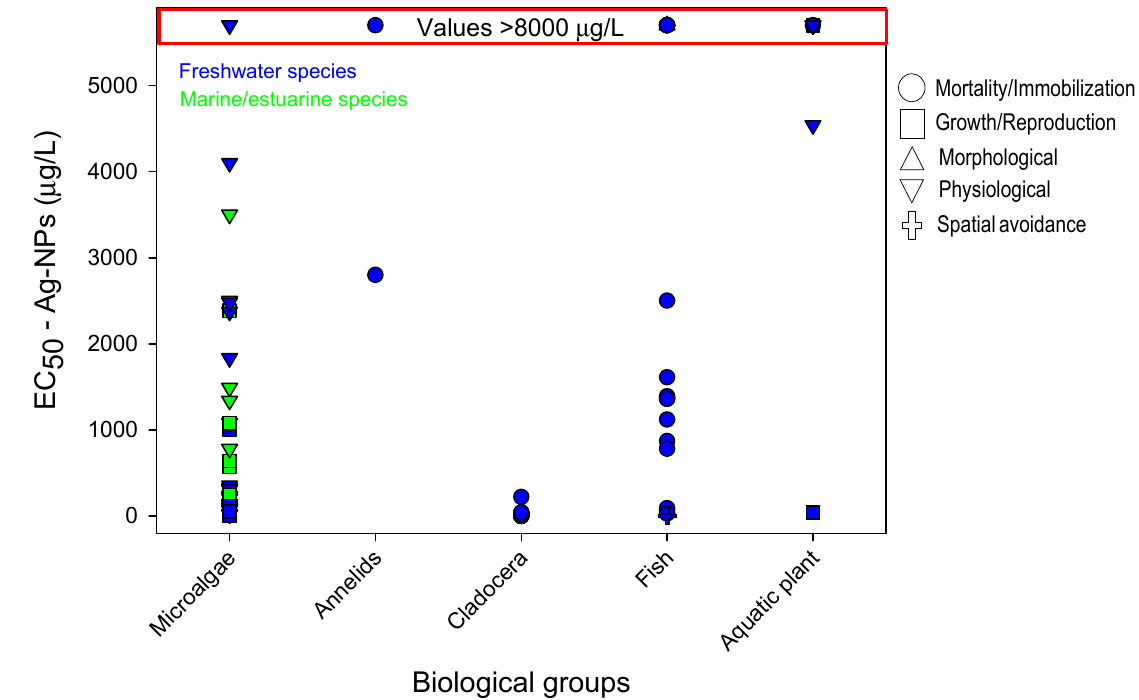
Figure 2. Sensitivity profile for the biological groups exposed to glyphosate-based on the EC 50 values. The effects, represented by different symbols, were classified according to Table 1. Data in blue and green represent, respectively, freshwater and estuarine/marine species. Data shown in the red zone represent results whose EC 50 values are higher than 500 mg/L; therefore, the scale should not be considered in this zone (see real data in Table S2).